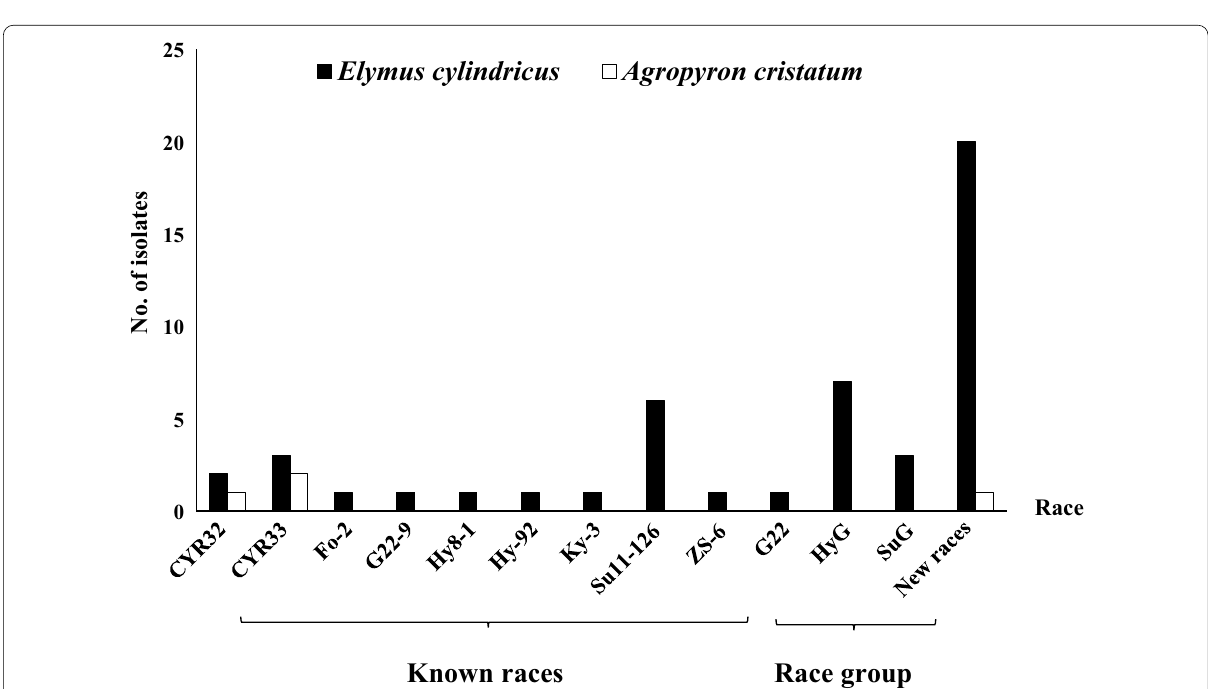
Fig. 6 The number of Puccinia striiformis f. sp. tritici isolates belonging to different races. The Pst isolates were recovered from aeciospores appearing on barberry leaves after inoculation with basidiospores derived from germinated teliospores (collected from grass species, A . cristatum and E . cylindricus , in middle March, 2014 in Tianshui, Gansu Province, China). Races were determined based on virulent/avirulent reactions of Pst isolates on a set of 19 Chinese differential hosts. Race group indicates rust reaction types on the Chinese differential varieties. The designations G22, HyG and SuG indicate that the Pst isolates were virulent on the wheat genotype Guinong 22, Hybrid 46 and Suwon 11,